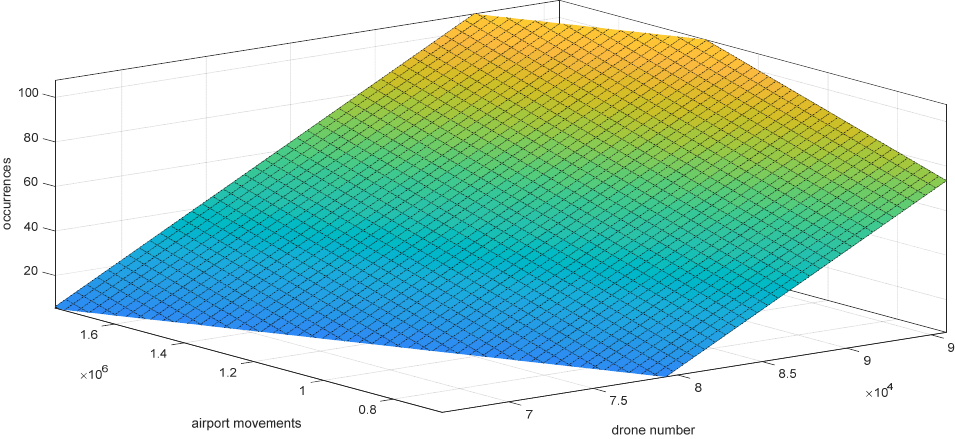
Figure 9. AVI model for the Italian the yearly number of drone intrusions as a function of the total number of drones and the yearly number of airport movements.